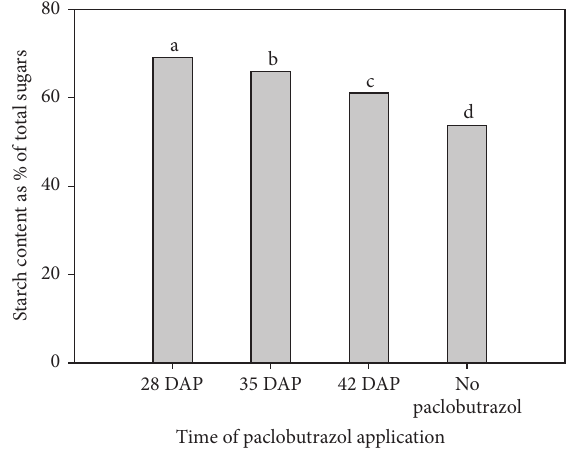
Figure 3: Effect of time of paclobutrazol application on potato tuber starch content as a % of sugars.